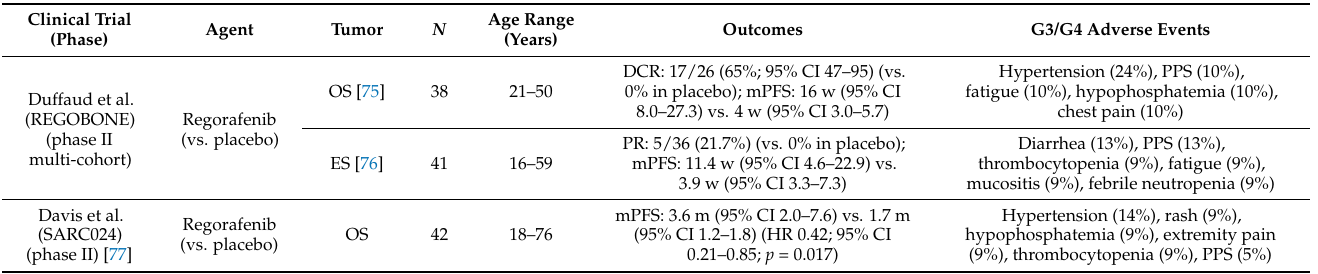
Table 1. Phase II trials with TKIs in bone sarcomas. OS: osteosarcoma; ES: Ewing sarcoma; CI: confi- dence interval; mPFS: median progression-free survival; OS: overall survival; PR: partial response; SD: stable disease; DCR: disease control rate (PR + SD); ORR: overall response rate; w: